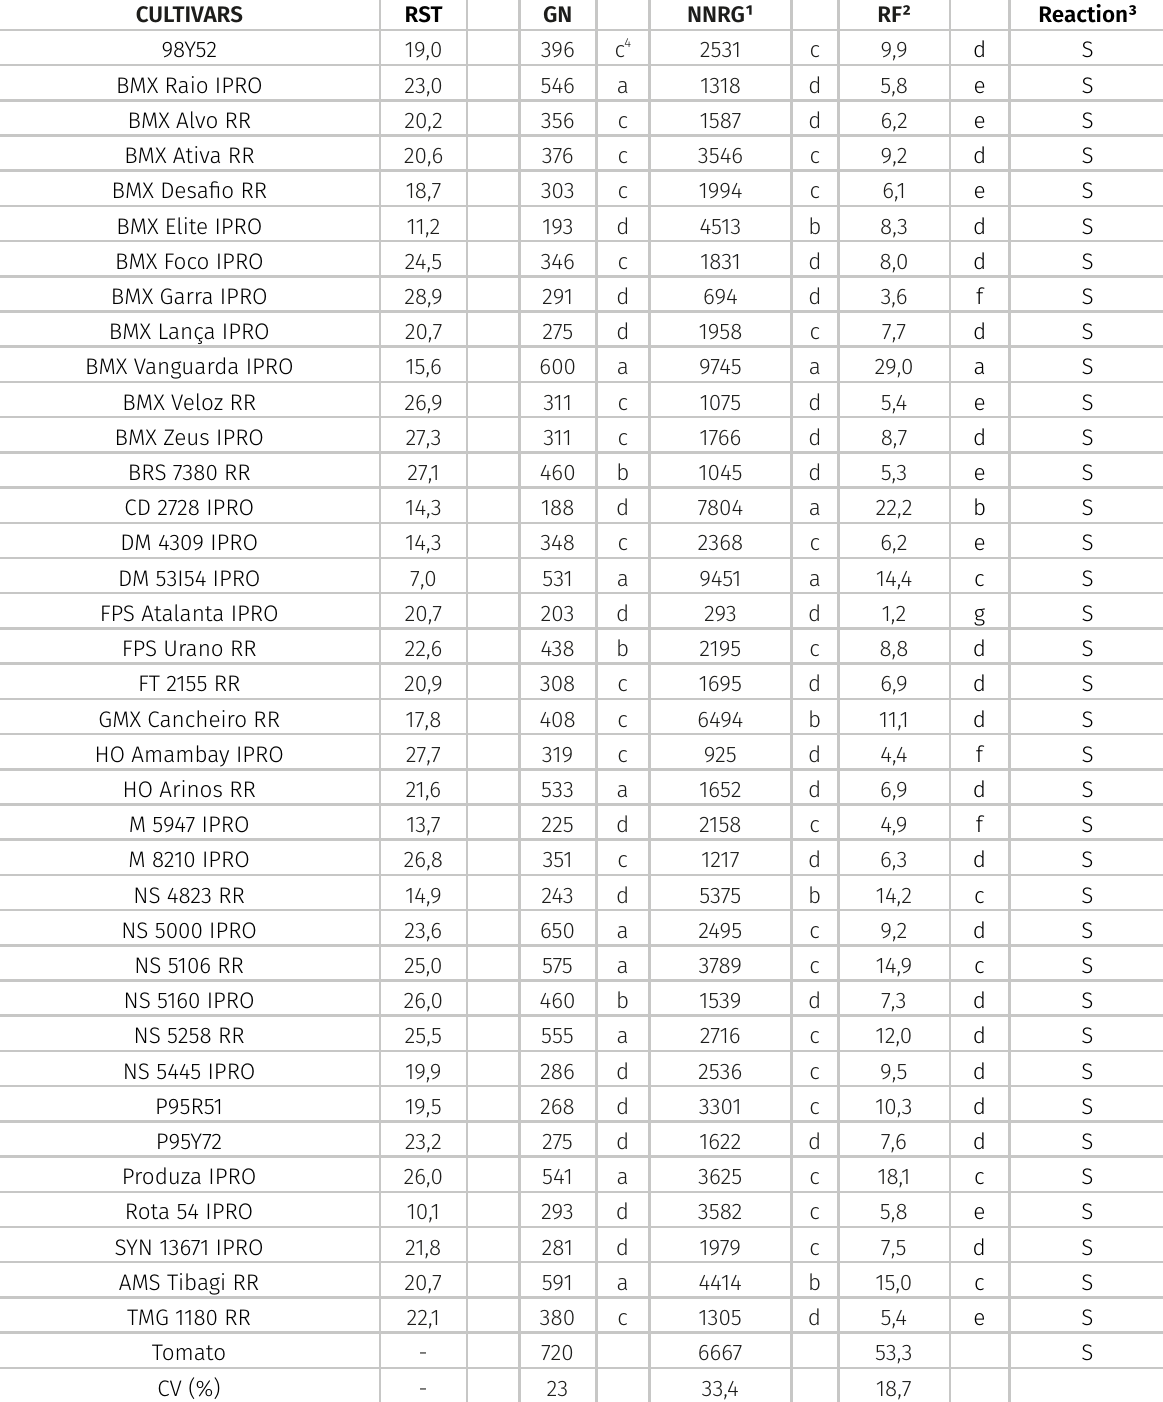
Table II. Root system weight (RST), gall number (GN), number of nematodes per root gram (NNRG), reproduction factor (RF) and reaction of Meloidogyne javanica in soybean